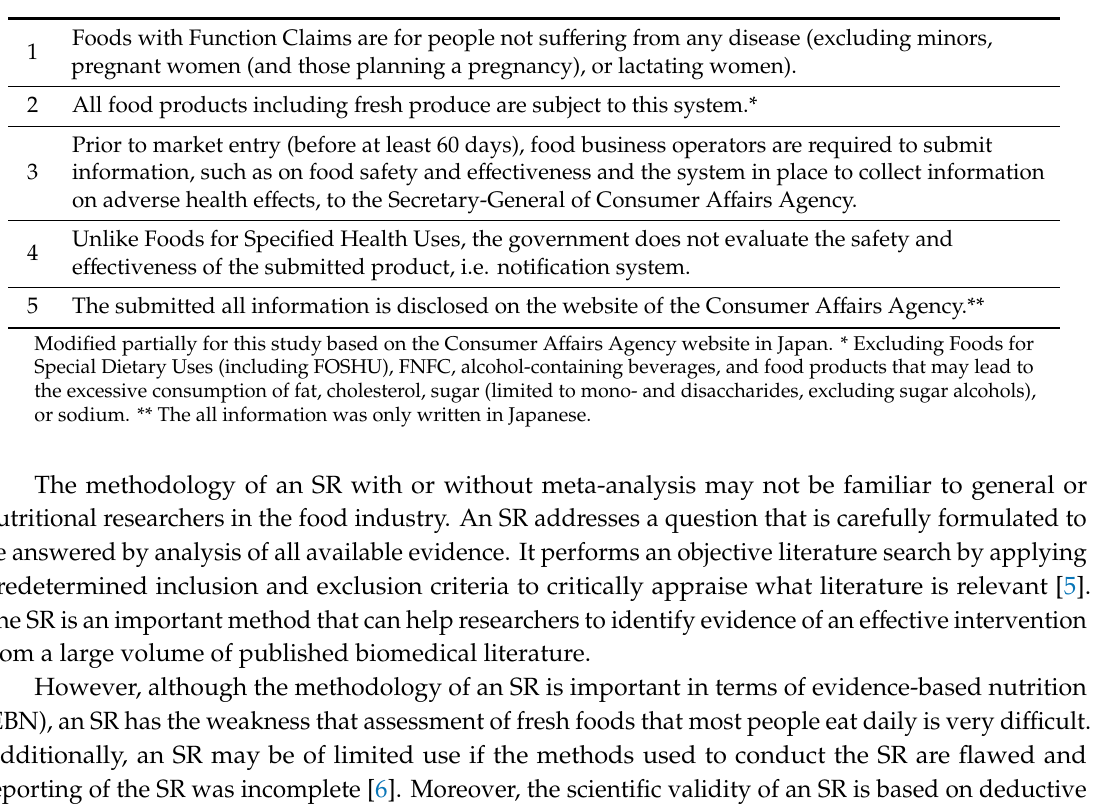
Table 1. Characteristics of the foods with function claims in